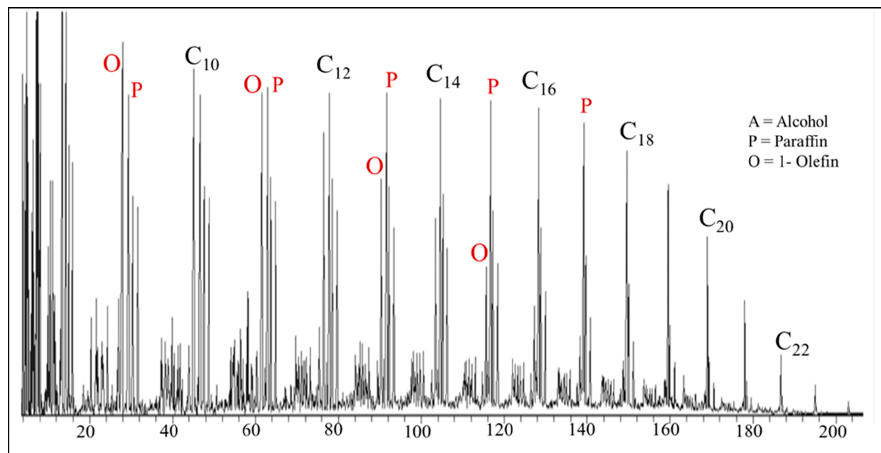
Figure 13. A chromatograph of the products produced with a lithium doped iron catalyst. The x-axis is retention time in minutes. Reaction Conditions: 270 °C, 12.1 bar, WHSV = 2, and H 2 /CO = 0.7.